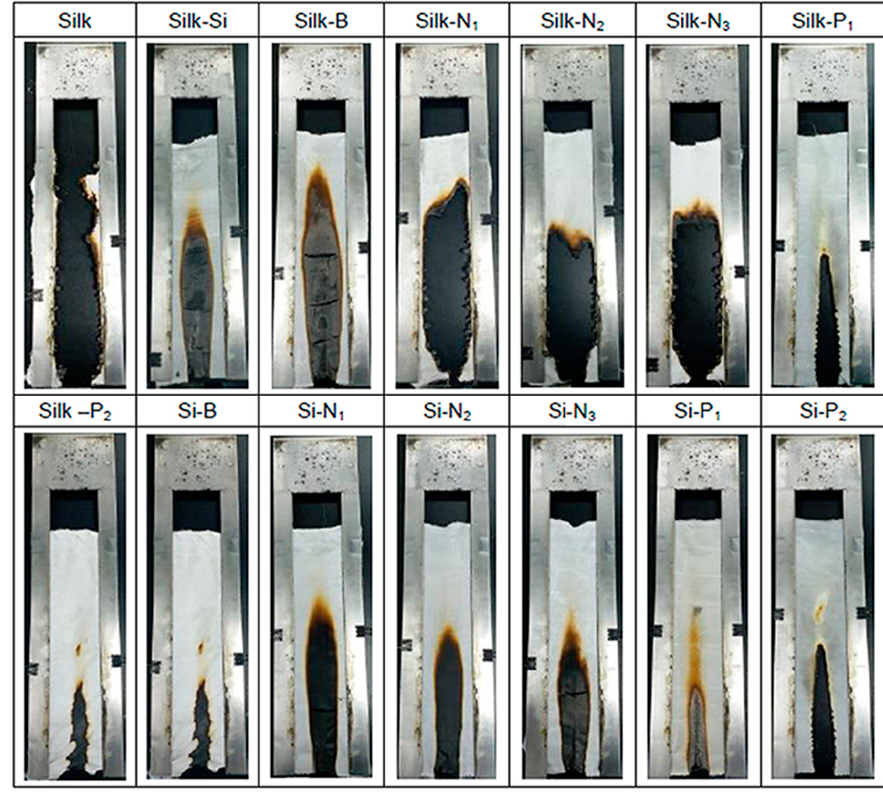
Figure 4. Vertical burning images of original silk and the treated silk fabrics.